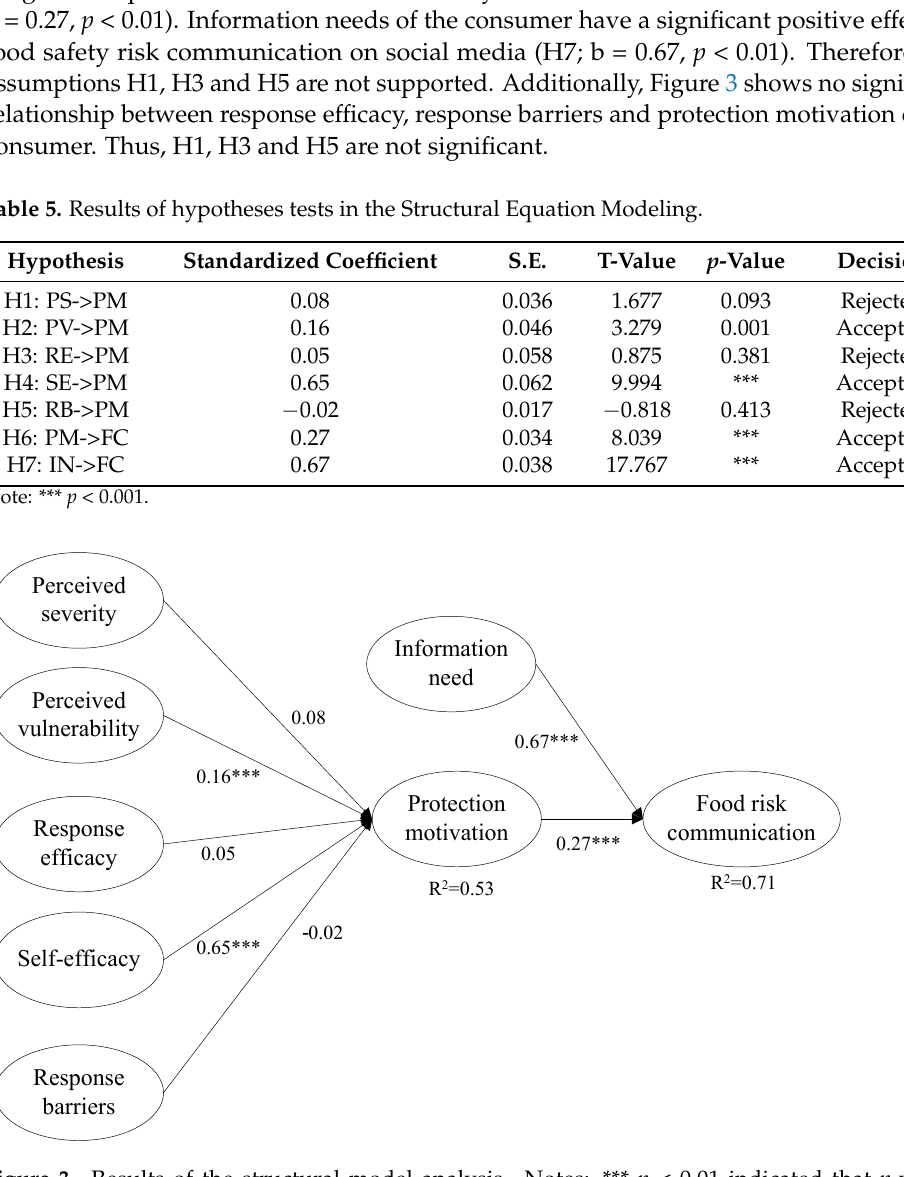
Figure 3. Results of the structural model analysis. Notes: *** p < 0.01 indicated that p -values are significant.